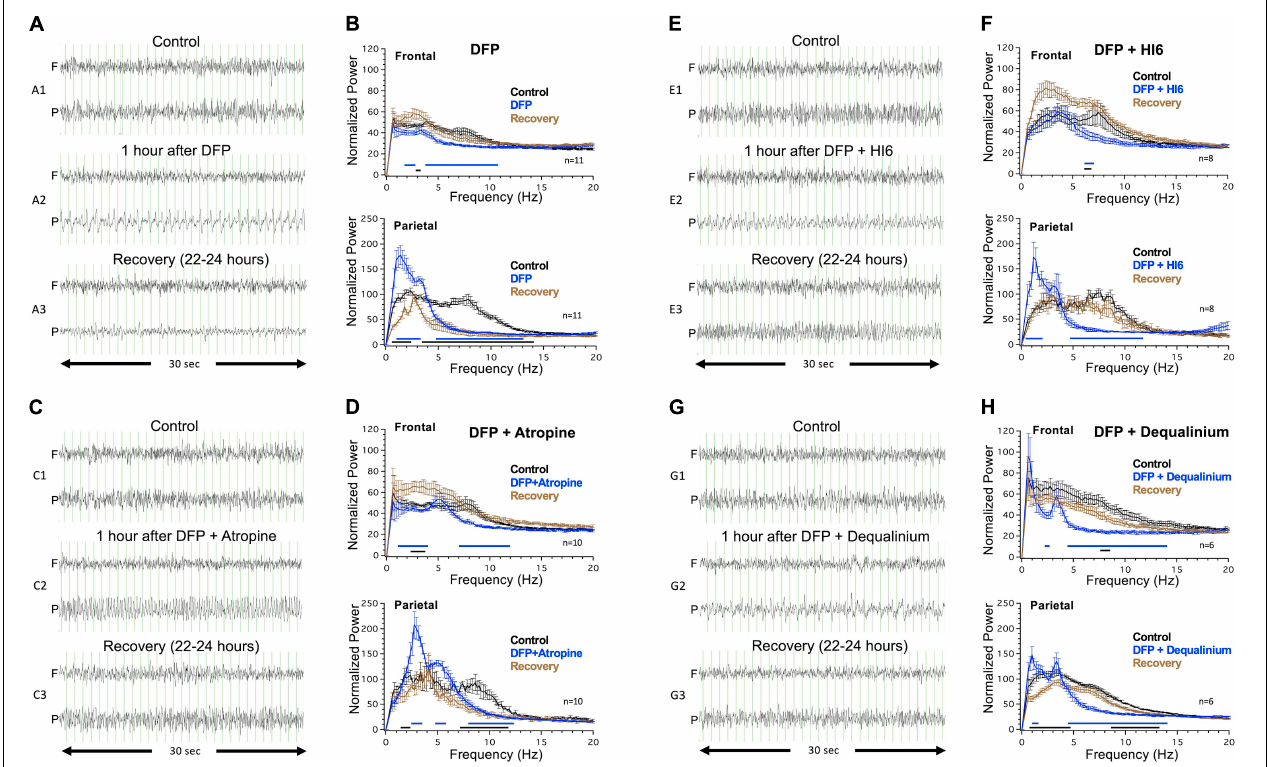
FIGURE 2 | Electroencephalogram (EEG) activity in response to injections of diisopropylfluorophosphate (DFP) alone or DFP with treatment. Left panels show example traces before (top traces, A1–G1 ), immediately after (middle traces, A2–G2 ), and 22–24 h after DFP or DFP with treatment (bottom traces, A3–G3 ). Traces are shown for frontal (F) and parietal electrodes (P). Vertical grid lines represent 1 s intervals. Right panels display power analysis across a 15 min sampling period that includes the representative example traces. Power analysis are for control records (black), records immediately following DFP alone or DFP with treatment (blue), or recovery 22–24 h after injection (brown). Right top panel show analysis from frontal electrode 1, and right bottom panel show analysis for parietal electrode 2. Lines below the graph are regions where there was a statistically significant difference (Two-way ANOVA, Tukey multiple comparisons test, P < 0.05) in normalized power between control and acute EEG response (blue line), or control and recovery (black line). Data is for analysis of 11 mice for DFP alone, 10 mice for DFP with atropine, eight mice for DFP with HI6, and six mice for DFP with dequalinium